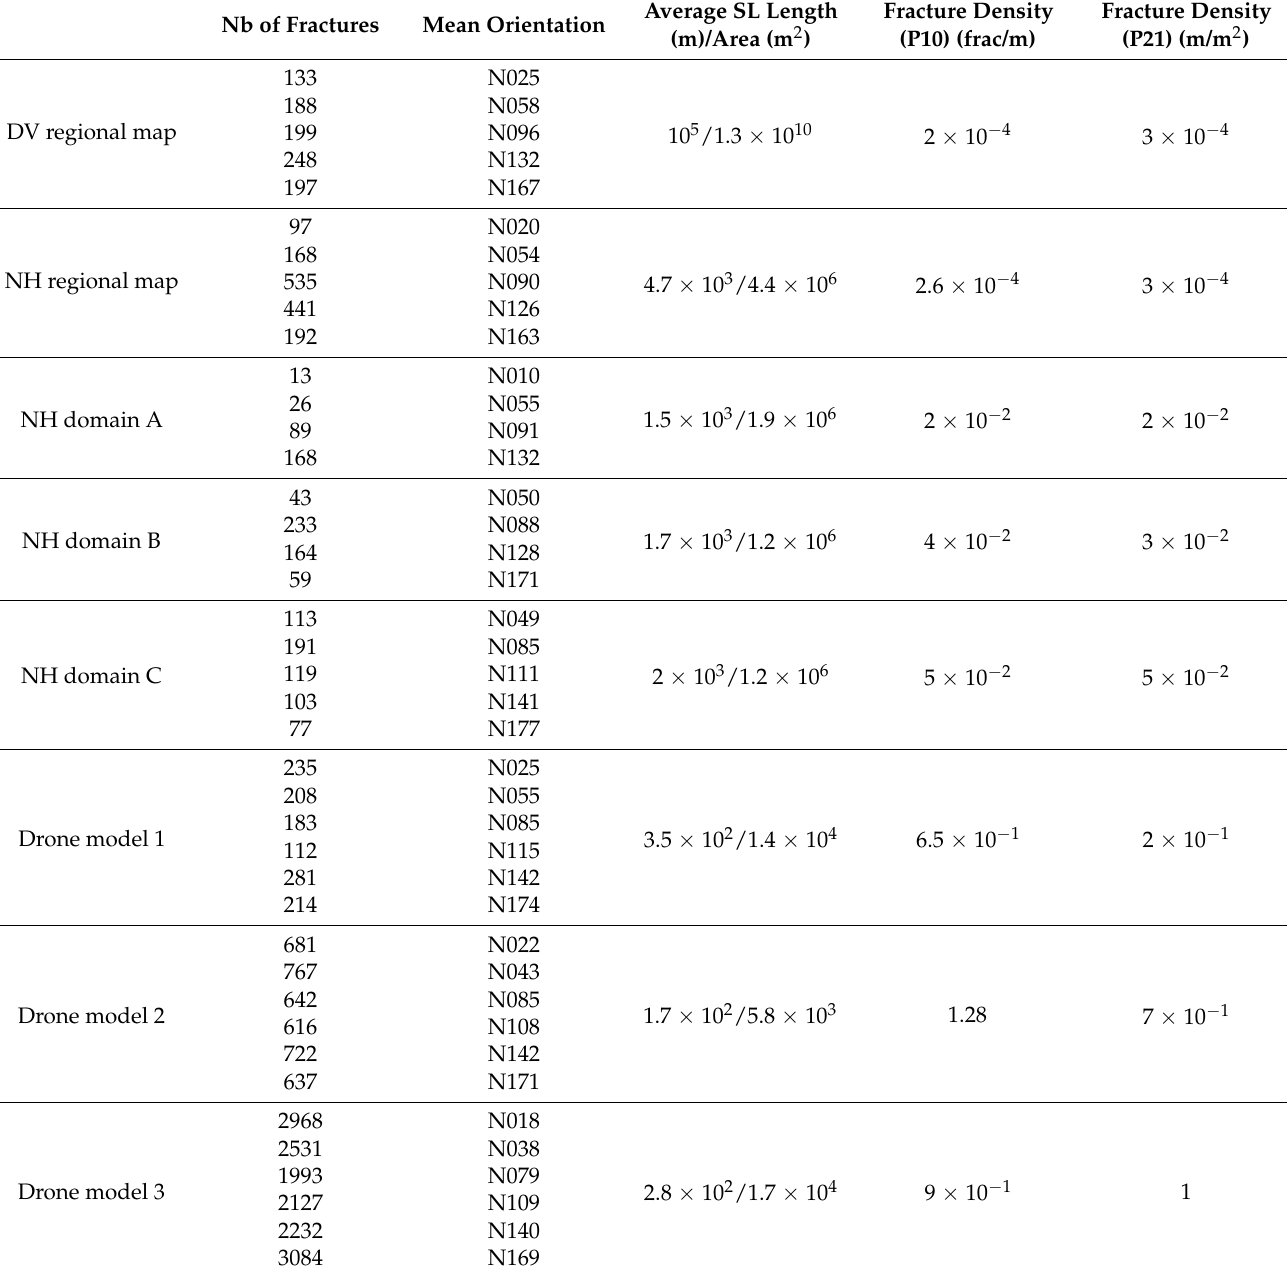
Table 1. Spatial statistics of 2D samples acquired at large scale (DV and NH regional maps) and outcrop scale (Drone models). Two Scanlines (SL) at least were generated for calculating the fracture density (P10). The length average is